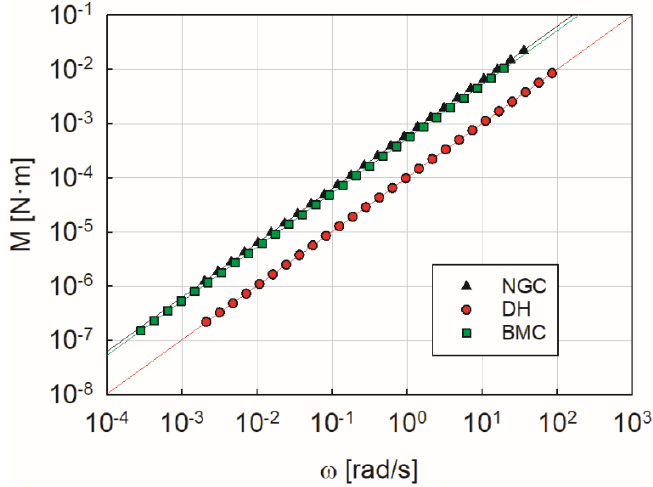
Figure 4. Torque as a function of rotation rate for the three geometries. The straight solid lines are linear regressions of the data. Table 2. The geometrical constants c SS and c SR for the three geometries. The values of c SS and c SR provided by Anton Paar are also reported along with those obtained in this work. The calibration constants K for the DH and the BMC derived from the calibration procedure are also reported.